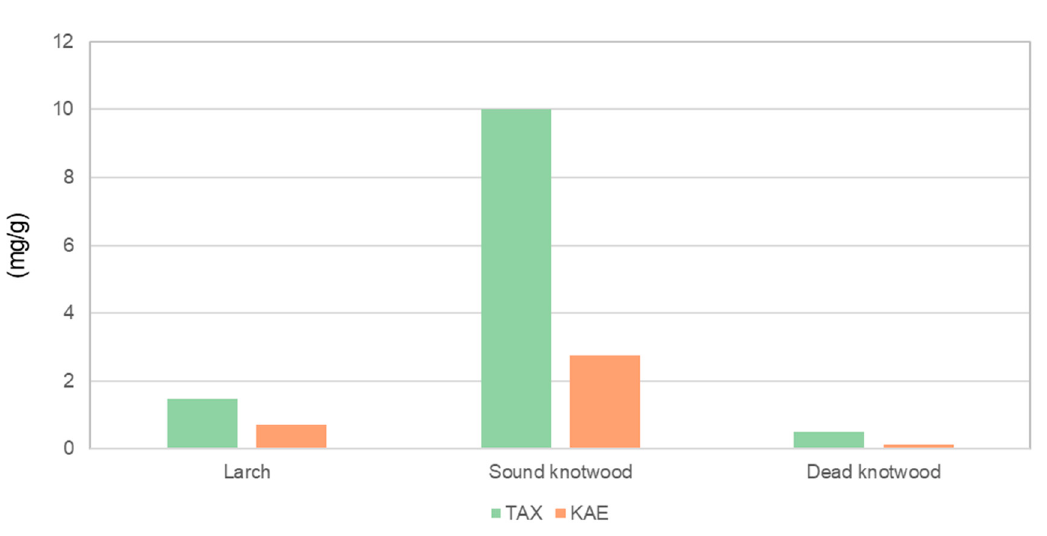
Figure 2. Content and composition of two main phenolic compounds of wood, sound knot and dead knot of larch trees (TAX—taxifolin, KAE—kaempferol).